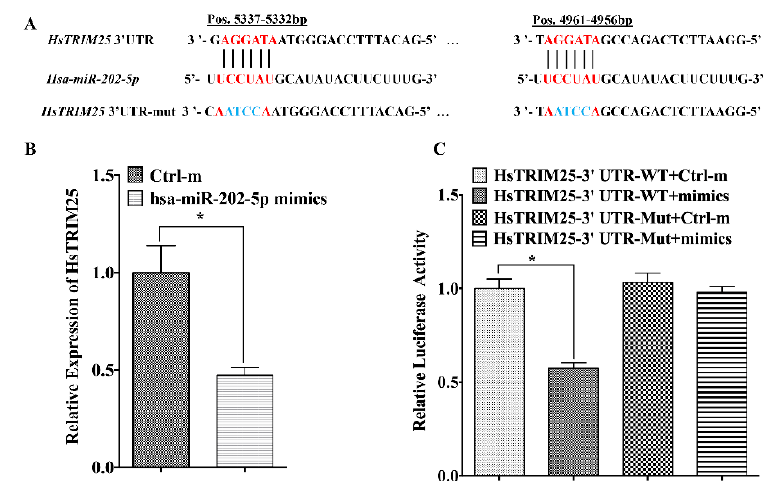
Figure 5. Human tripartite motif-containing protein (HsTRIM25) is targeted by hsa-miR-202-5p. A ) Two potential hsa-miR-202-5p binding sites in the HsTRIM25-3 ′ UTR and its mutants. B ) Overexpression of hsa-miR-202-5p in HEK 293T cells changed the endogenous HsTRIM25 mRNA level as measured by qRT-PCR. C ) The luciferase reporter vector encoding wild-type or mutated 3 ′ UTRs from HsTRIM25 was co-transfected into HEK 293T cells with hsa-miR-202-5p mimics or Ctrl-m, and luciferase activity was measured 48 h later. Asterisks indicate the significant differences between groups (*: p < 0.05).